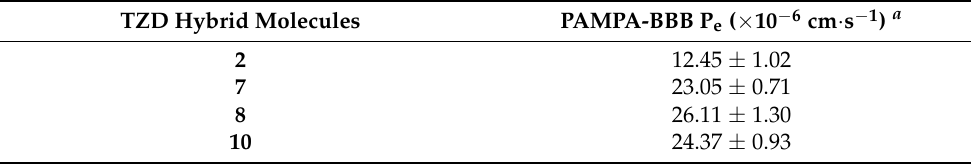
Table 3. PAMPA-BBB permeabilities of TZD hybrid molecules 2 , 7 , 8 , and 10 .